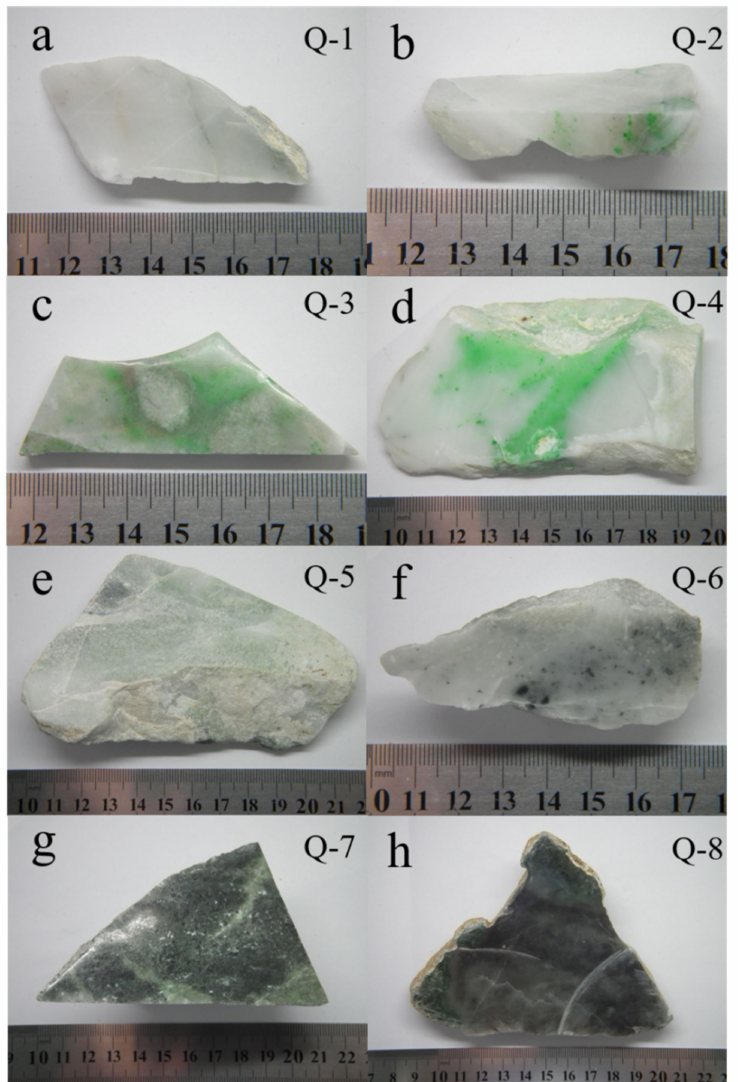
Figure 1. Selected samples of Philippines rock with different colors. ( a ) White sample Q-1; ( b – d ) green samples Q-2, Q-3, Q-4; ( e ) cyan-gray sample Q-5; ( f ) white sample with black spots Q-6, ( g ) dark green sample Q-7; ( h ) brown sample